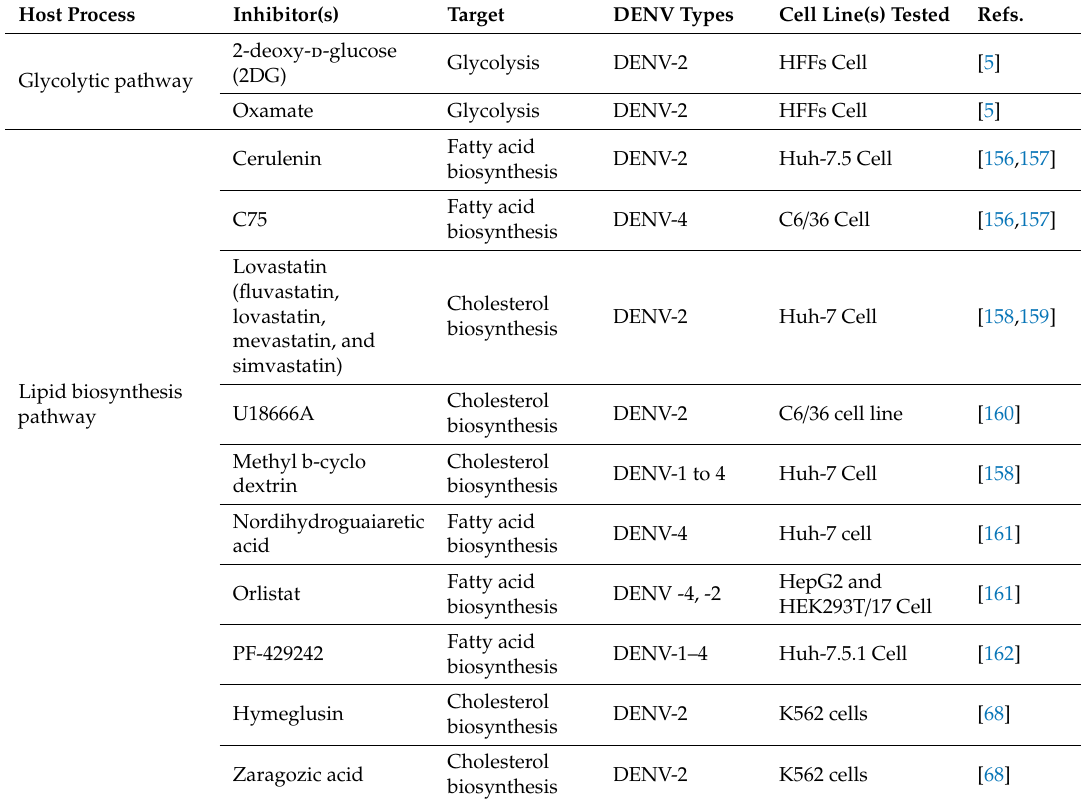
MAP kinase-activated protein kinase, RIG-I = retinoic-acid inducible gene I, IMP dehydrogenase = Inosine-5 (cid:48) -monophosphate